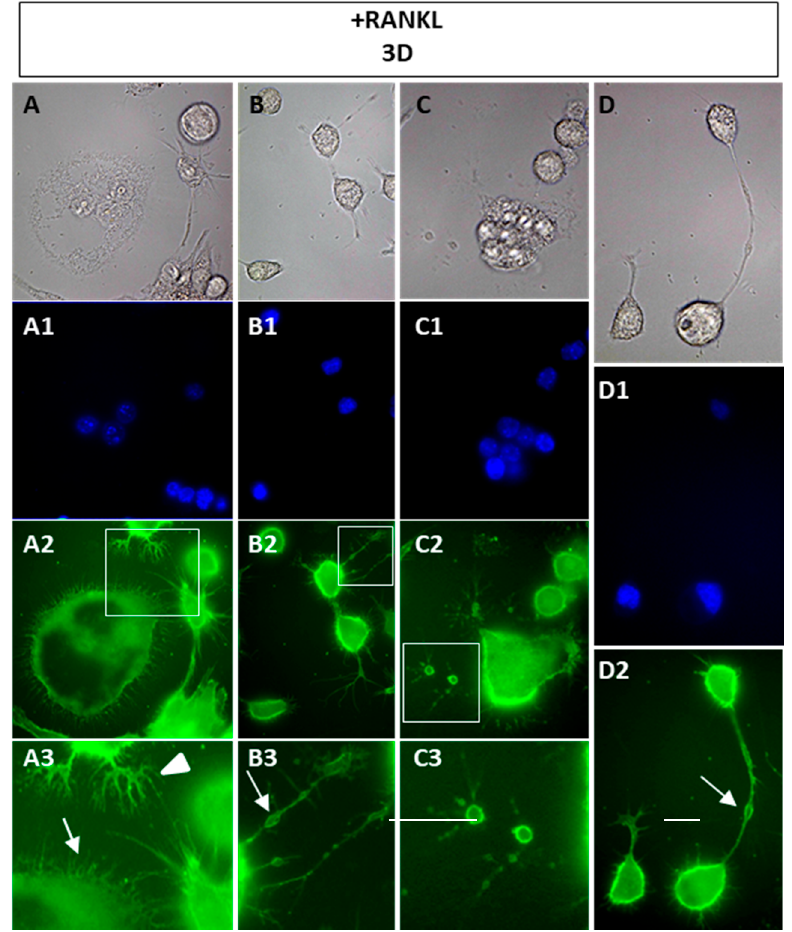
Figure 2. Cellular extensions of 3 days RANKL-stimulated cells. Cells were stained with wheat germ agglutinin (WGA)-FITC and mono or multinucleated cells are shown. ( A – D ) brightfield. ( A1 – D1 ) Dapi staining. ( A2 – D2 ) direct immunofluorescence with WGA-FITC. ( A3 – C3 ) 2.5 × magnification of A2 , B2 , and C2 , respectively. The data shown represent two independent experiments with comparable outcomes. Magnification 40×. Scale bars of 20 µm.